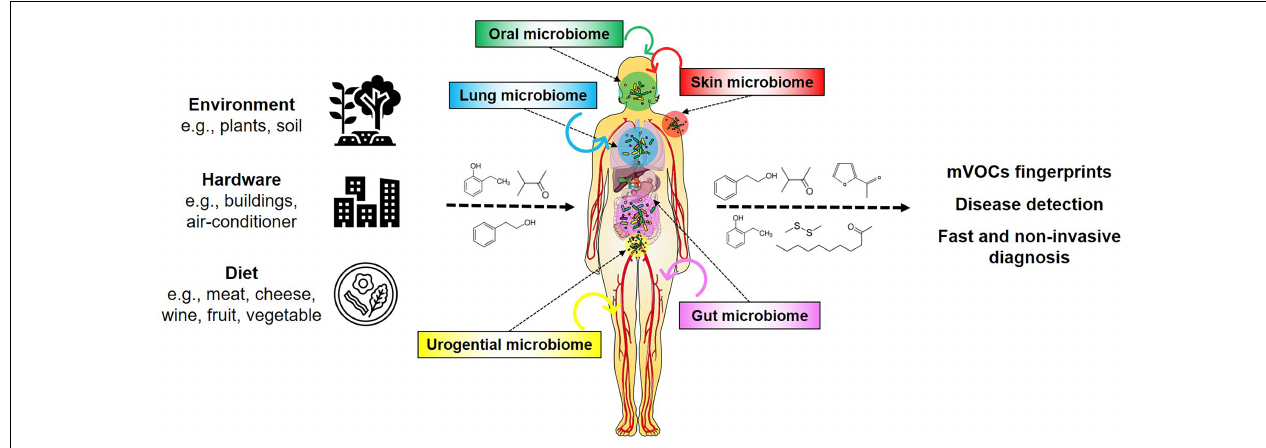
FIGURE 1 | mVOCs and the human holobiont. Microorganisms appear universal in the environment, on hardware, on foodstuff and in/on humans. Their metabolism produces many compounds, including volatiles. These volatiles influence and affect humans. mVOCs released of the human microbiomes are potential biomarkers for non-invasive